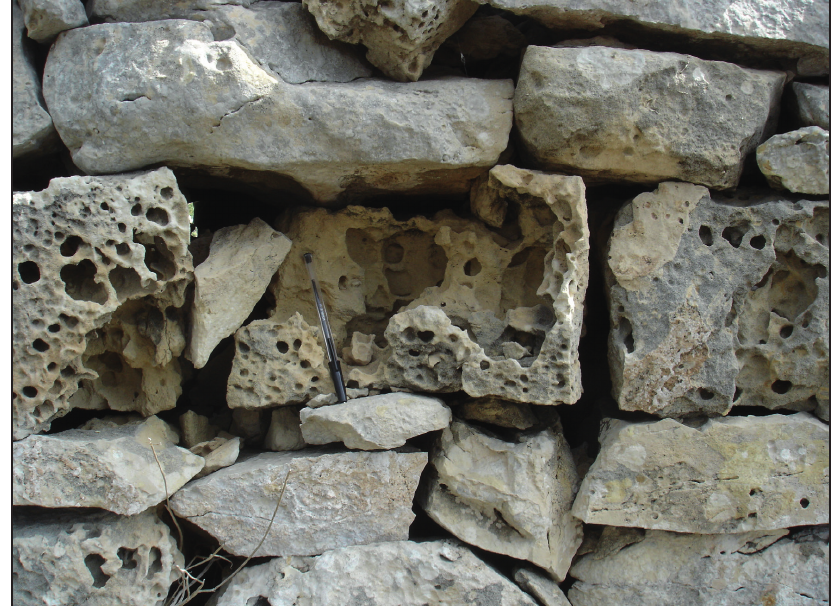
Figure 20. Weathering by tafoni of the exposed face of a cubic block of rock in a field boundary wall upslope from the ˙Zonqor shore. The wall is estimated to be c. 400 years old [62]. The face of the block has been eroded by tafoni to a depth of 150 mm, and serves as a first approximation benchmark of the weathering and erosion rate of boulders in the local environment (pen is 150 mm